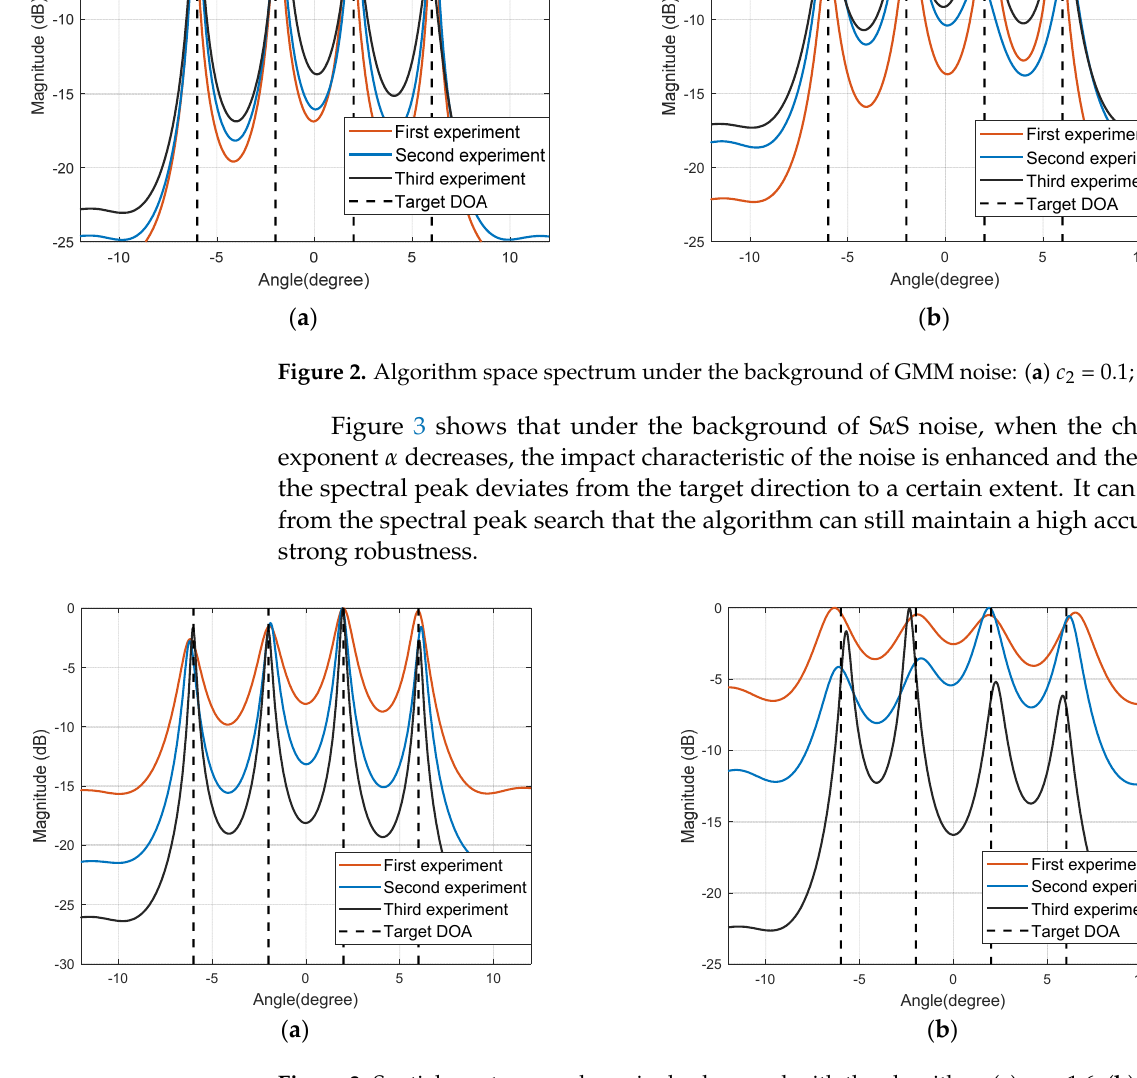
Figure 3. Spatial spectrum under noise background with the algorithm: ( a ) α = 1.6; ( b ) α =